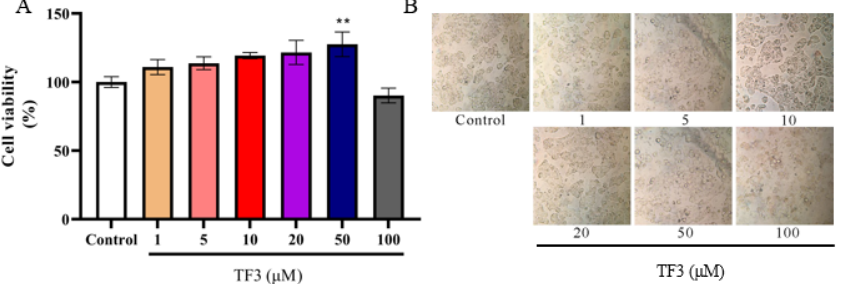
Figure 1. The effect of TF3 on HepG2 cell viability ( A ) and cell morphology ( B ). Control, DMEM medium culture; TF3, DMEM medium containing different concentrations of TF3 (1, 5, 10, 20, 50, 100 μM) treating for 24 h. ** p < 0.01 versus control group.